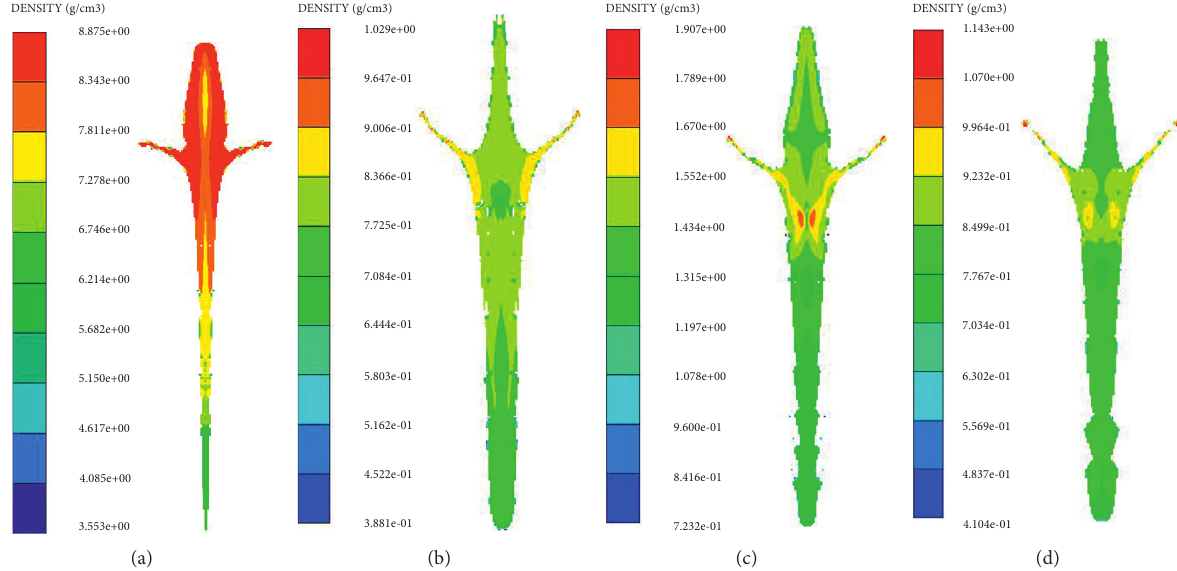
Figure 6: Density distribution of different material micro-jets at the distance of 2.5CD: (a) copper jet; (b) Teflon jet, (c) nylon jet; and (d) polycarb jet.